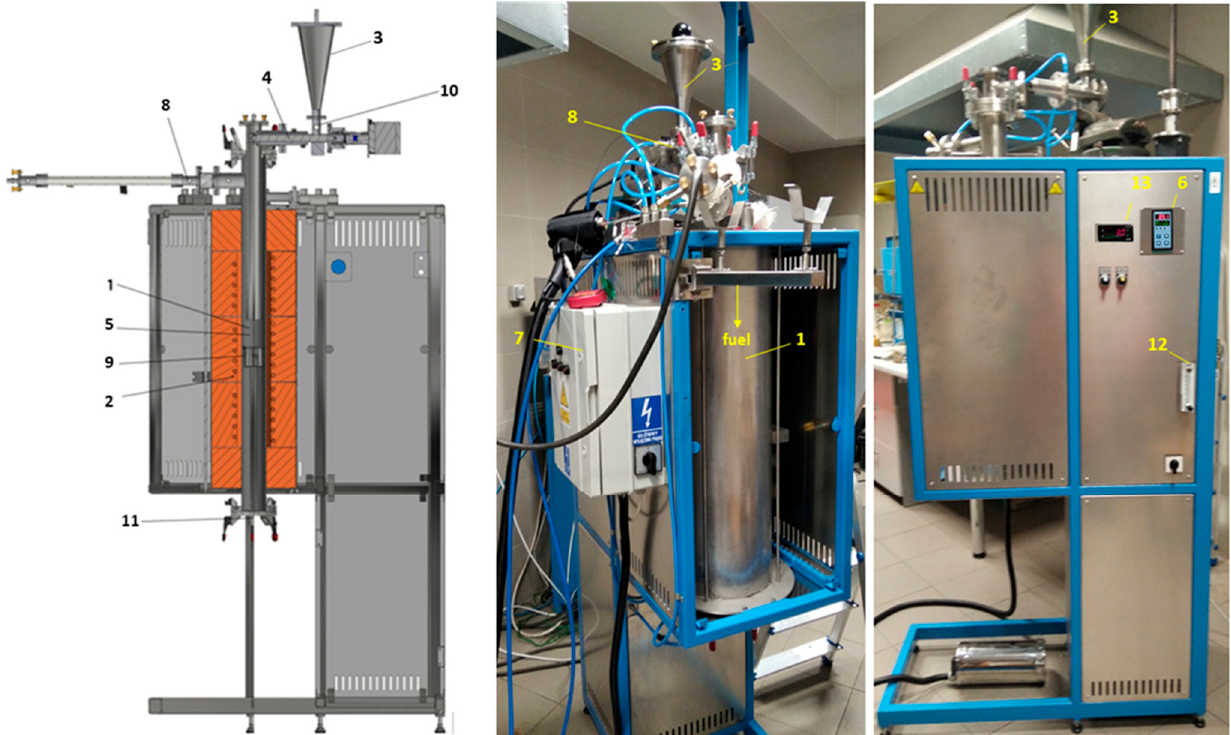
Figure 1. The scheme and photo of the research bench. The main element of the research bench is the combustion chamber (1), which is a pipe with a diameter of 76.1 mm, on which a three-sequence heating spiral (2) with a total power of 3.4 kW was wrapped. The pipe was thermally insulated to ensure maintenance of the desired temperature in the combustion chamber: 850 °C. Fuel/waste with a granulation of below 0.2 mm and a weight of about 30 g is served once to the charging tank (3) and then, using a screw feeder (4), to the combustion chamber. To adjust the temperature in the place of combustion (at the height of 737 mm from the feeder axis), the Ni-NiCr thermoelement was installed (5). This thermoelement is connected to the temperature regulator (6) and power controller (7). In addition, the temperature in the combustion chamber at the measurement site is controlled using the second Ni-NiCr thermoelement. The burning of waste along the height of the combustion chamber is continuous and concurrent with primary air. A connector (8) measures the gas emissions from the tested waste during combustion at the combustion chamber outlet. A container from the bottom of the combustion chamber enables the ash collection (9) in order to analyse its composition further. The sealing of detached elements is cooled using water. The total air for combustion (10 L/min) is supplied to the combustion chamber as primary air (10) and secondary air (11). The secondary air enables the burning of waste in a container of ash. The total air is measured using the rotameter (12). The spigot located behind the rotameter evenly separates the primary and secondary air. The fuel/waste is delivered to the combustion chamber using the screw feeder (4) with a rotational speed of approx. 0.63 turnover/min